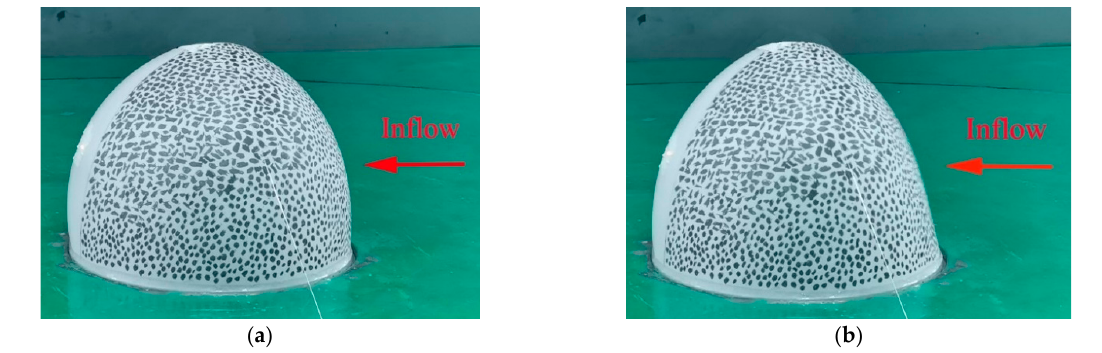
Figure 13. Test photos of transient deformation under different wind speeds: ( a ) u = 4 m/s and ( b ) u = 11 m/s.